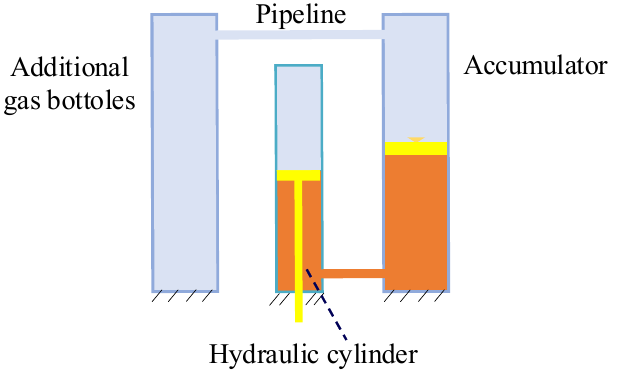
Figure 3. Schematic layout of the compensator.